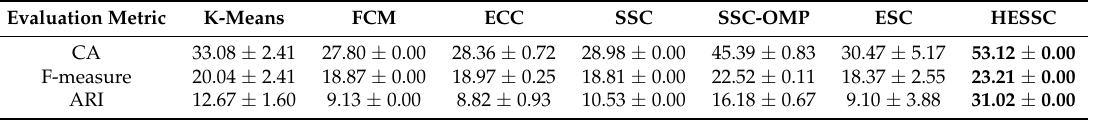
Table 1. Quantitative assessment on the performances of applied clustering algorithms on the first drill-core sample. The evaluation metrics are reported in mean and standard deviation over 10 trials.